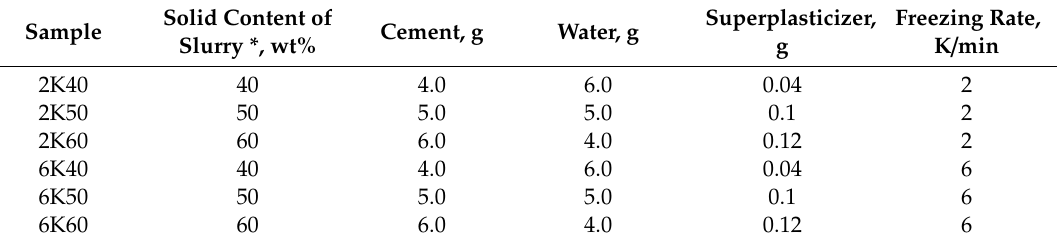
Figure 1. Schematic of the fabrication of cement membrane supports. Table 1. Overview of the specimens characterized in this